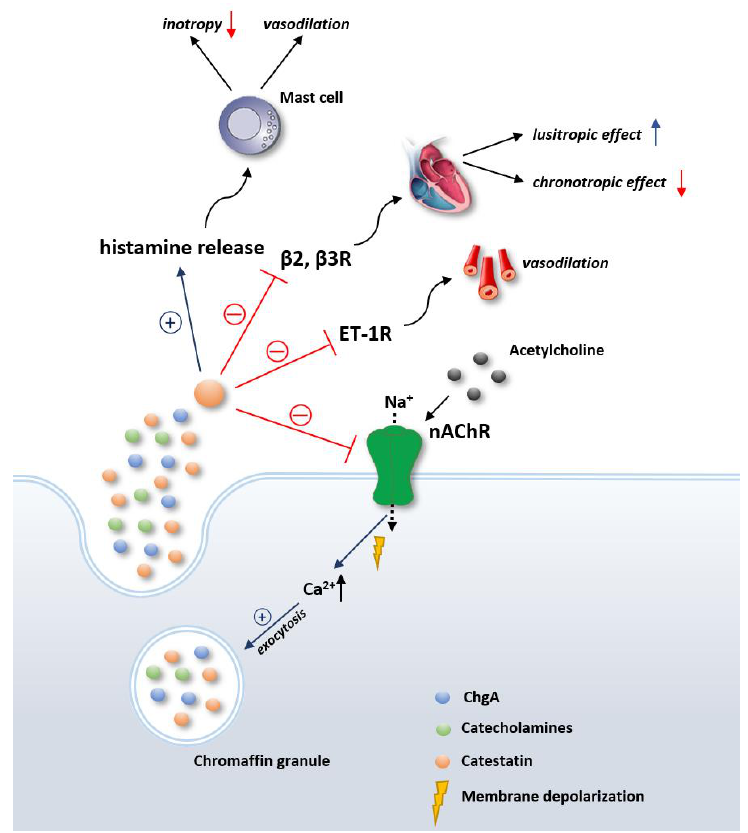
Figure 1. Various receptors through which catestatin exerts its functions. Inhibition of nAchR interferes with membrane depolarization, which then prevents influx of calcium needed for exocytosis of chromaffin granules. Red lines depict inhibition; blue lines indicate stimulation. Abbreviations: ET-1R: endothelin-1 receptor; nAchR: nicotinic acetyl choline receptors; β2, β3R: beta 2 and beta 2 receptor; ChgA: chromogranin A.